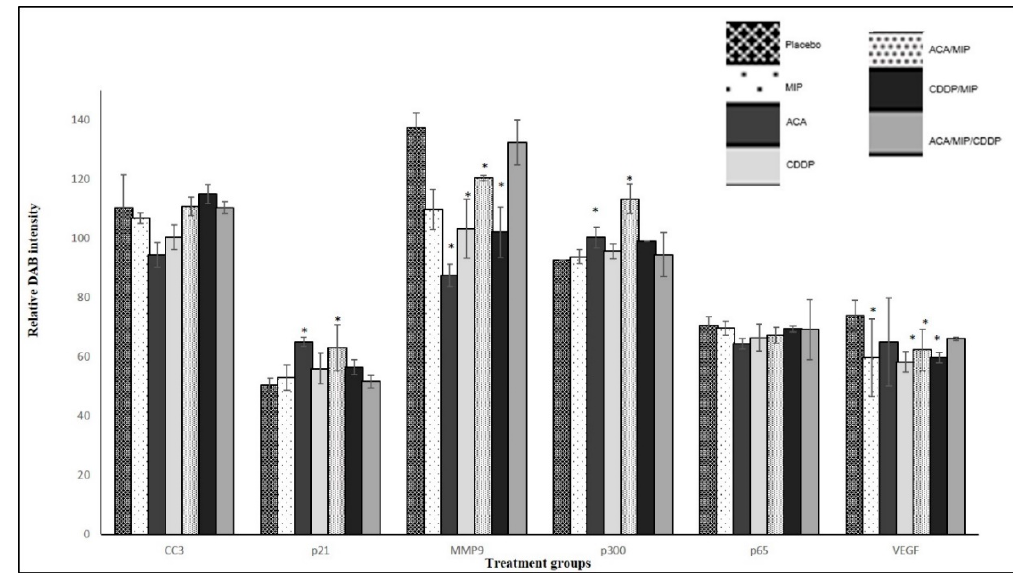
Figure 5. Quantification of the relative intensity of IHC DBA staining on 4T1 breast tumor sections treated with various 1 ′ -S-1 ′ -acetoxychavicol acetate (ACA), Mycobacterium indicus pranii (MIP), cisplatin (CDDP) standalone, double, and triple combinations. Images were captured using an inverted Nikon Eclipse TS 100 microscope (Nikon Instruments, Tokyo, Japan), and DAB intensity was quantified using the Nikon NIS-BR Element software (Nikon Instruments, Tokyo, Japan). Data for all NF- κ B regulated proteins and inflammatory biomarkers were presented as the mean ± standard deviation (SD) of three independent replicates. Statistically significant changes between placebo and treatment groups at fifth week are indicated as * for p < 0.05.